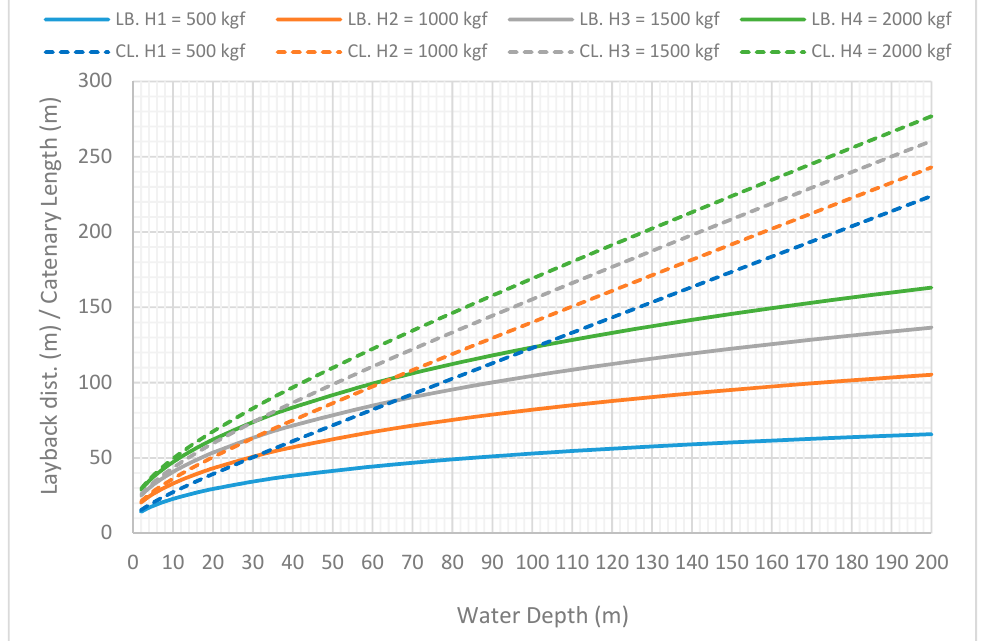
Figure 4. Layback distance (LB) and catenary length (CL) using various bottom tension values (500 kgf–2000 kgf) and water depths (2 m–200 m).